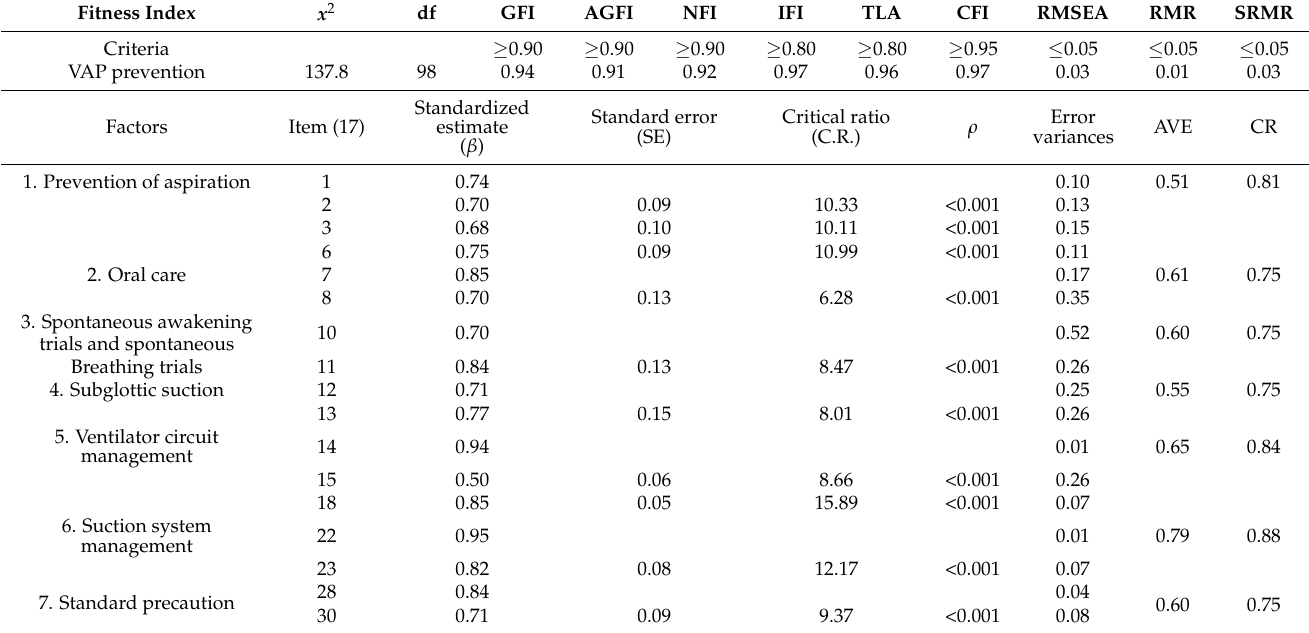
Table 3. Confirmatory factor analysis findings ( n =